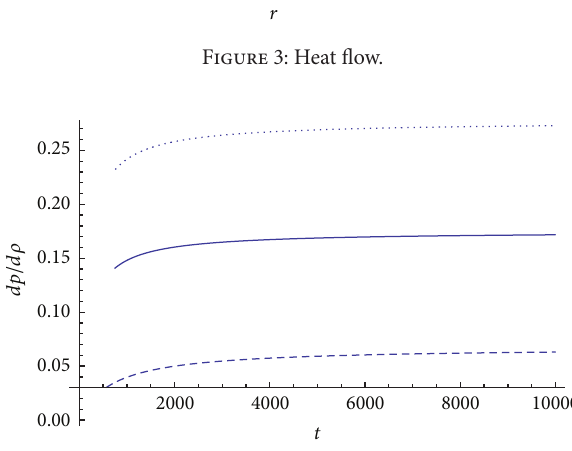
Figure 1: Energy density 𝜌 .